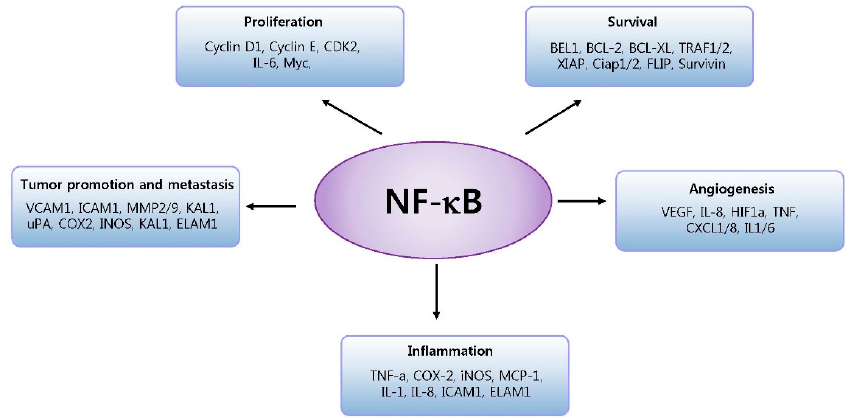
Figure 2. NF- κ B activation affects hallmarks of cancer and inflammatory diseases through the transcription of genes involved in cell proliferation, survival, angiogenesis, inflammation and tumor promotion and metastasis. BCL2, B-cell lymphoma protein 2; BCL-XL, also known as BCL2-like 1; BFL1, also known as BCL2A1; CDK2, cyclin-dependent kinase 2; COX2, cyclooxygenase 2; CXCL,